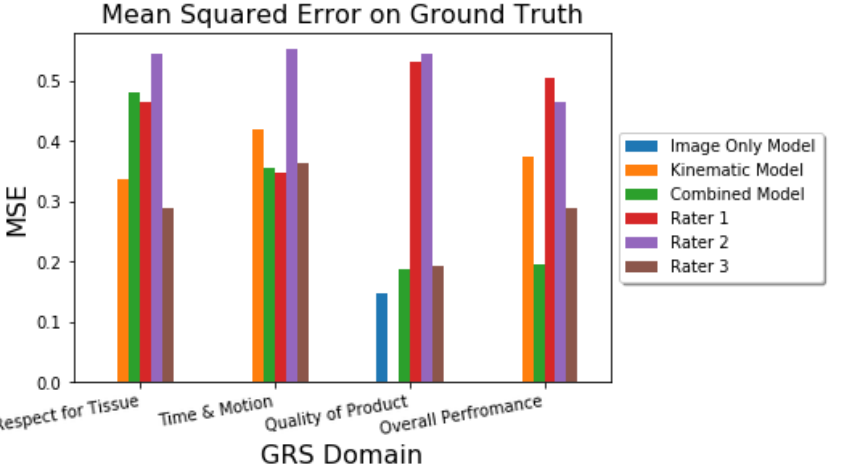
Figure 5. Graphical comparison of the MSE on the GRS Domains—lower MSE is